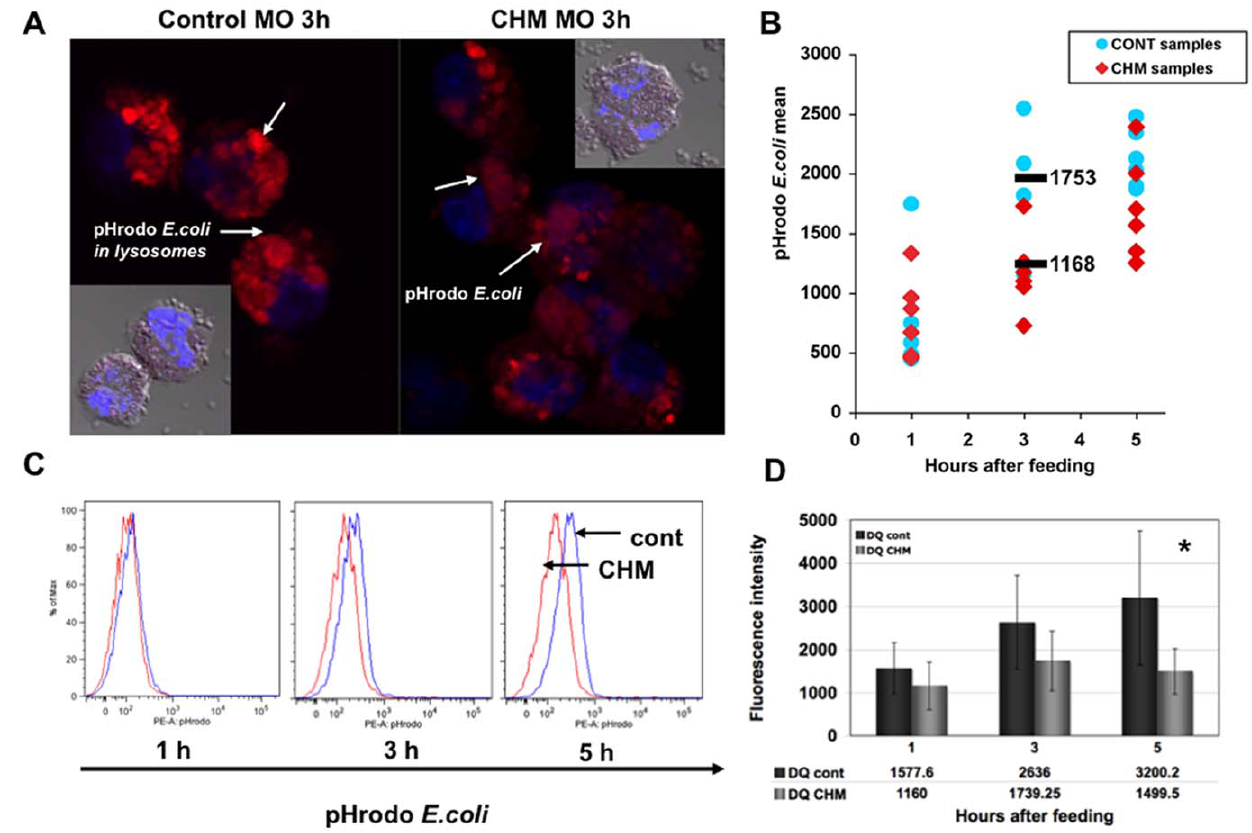
Figure 4. Levels of lysosomal acidification and proteolytic degradation in monocytes from CHM patients and age-matched controls. a. Intralysosomal acidification measurements were performed using E. coli BioParticles conjugated with pH dependent dye (pHrodo). Representative confocal images of the monocytes from patient CHM8 (right panel) and age matched control (left panel) feed with BioParticles at 3 h following the feeding. Acidic environment of the lysosomes caused an increase in fluorescent intensity of the BioParticles engulfed by the cells (in red, blue is a DAPI nuclear staining). b. Levels of fluorescence of the monocytes from CHM (n=7) and control (n=6) patients feed with BioParticles were analysed by flow cytometry, data expressed as a mean fluorescence intensity + / 2 SED at 1, 3 and 5 h following the feeding. Fluorescence intensity of pH dependent BioParticles taken up by monocytes from CHM patients was lower compared to the control at each time point. c. Representative FACS histograms showing shift in fluorescence intensity between the CHM and control monocytes fed with E. coli pHrodo at 1, 3 and 5 h. d. The efficiency of lysosome-mediated proteolytic degradation by monocytes from CHM (n=7) and control (n=6) patients assessed with DQ- ovalbumin particles. DQ-ovalbumin is a self-quenched substrate for proteases, which becomes fluorescent after proteolytic cleavage. Increase in fluorescence intensity, corresponding to the rate of proteolytic degradation of DQ-ovalbumin, was measured by flow cytometry. Data was expressed as a mean fluorescence intensity of the cells + / 2 SED at 1, 3 and 5 h following the feeding. Rates of proteolytic degradation were significantly lower in monocytes from CHM patients compared to control ( N p=0.005).